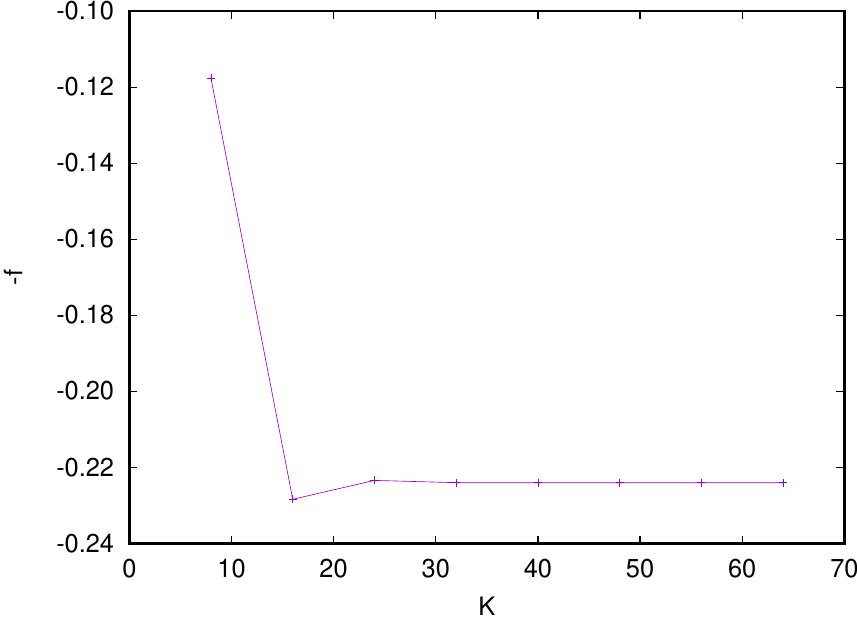
Figure 1 . Free energy density for D = 64 and m 2 = 0 : 01, (cid:21) = (cid:22) = 1 on V = 1024 2 .